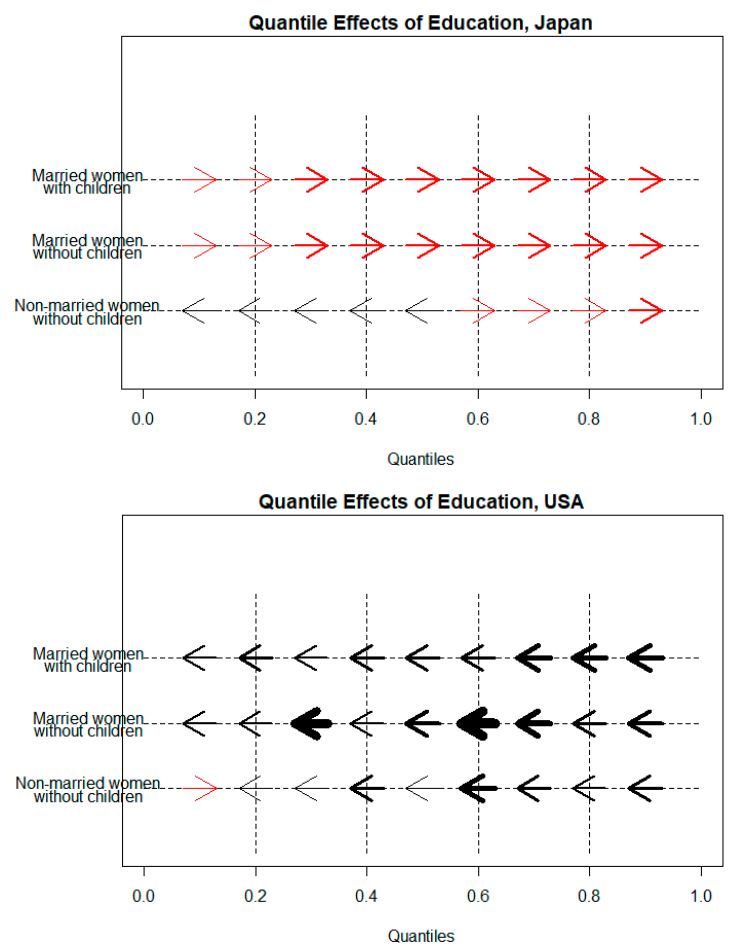
Figure 1. Quantile Effects of Education on Housework Participation.